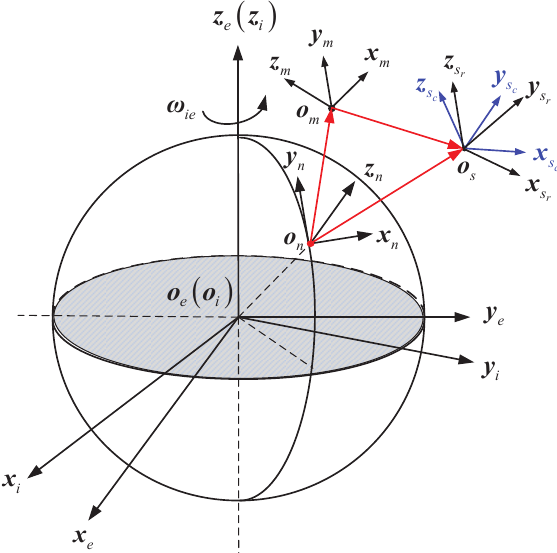
Figure 1. Definitions of the coordinate